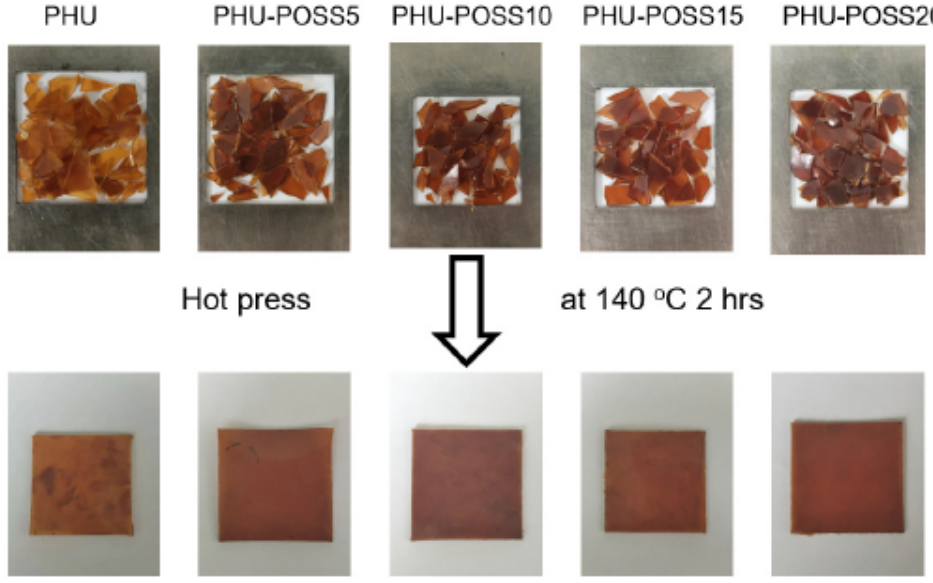
Figure 10. Photographs of PHU and PHU-POSS nanocomposites for reprocessing tests.